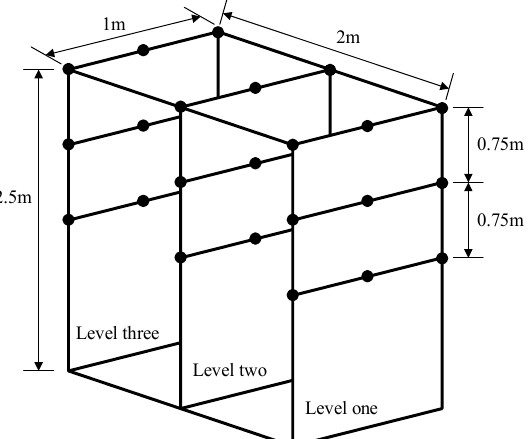
Figure 10. Test bench size and water-sensitive test paper point map. The black dots in the figure are the water-sensitive test paper points, and the water-sensitive test paper is hung on the front and back of each point.